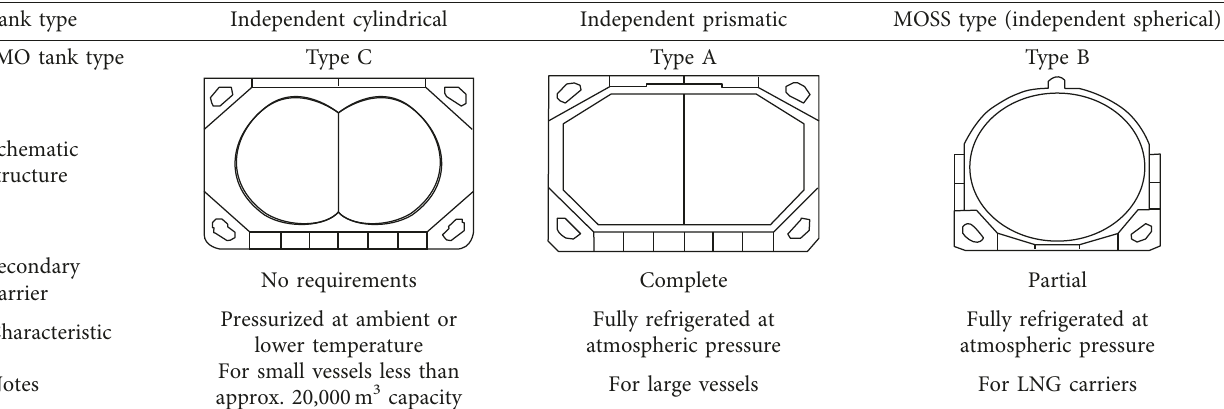
Table 1: Comparison of independent type tanks for LNG-fueled